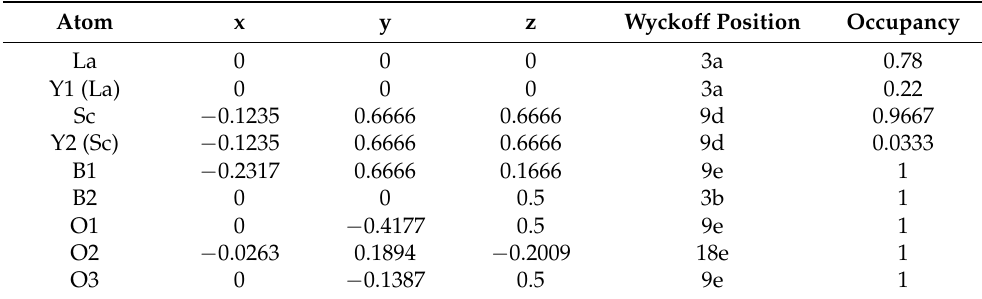
Figure 8. The experimental (in red), calculated (in blue), and difference (in grey) patterns after Rietveld analysis and refinement reliability parameters. (Reprinted with permission from ref. [13], copyright 2019 American Chemical Society). Table 2. Atomic coordinates and site occupancy fraction in the LYSB crystal. (Reprinted with permission from ref. [13], copyright 2019 American Chemical Society).